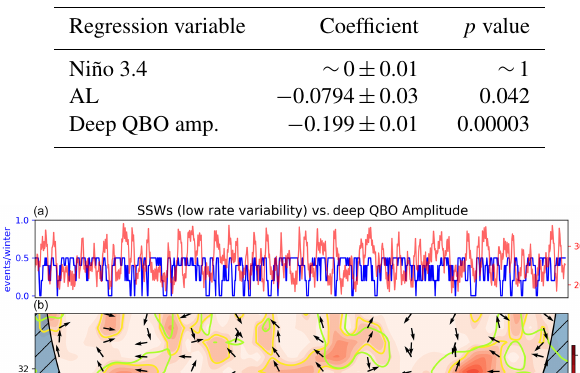
Table 3. Summary of results from multi-linear regression analysis of a Fourier-filtered version of SSW 5 years retaining power corre- sponding to periods greater than 60 years.